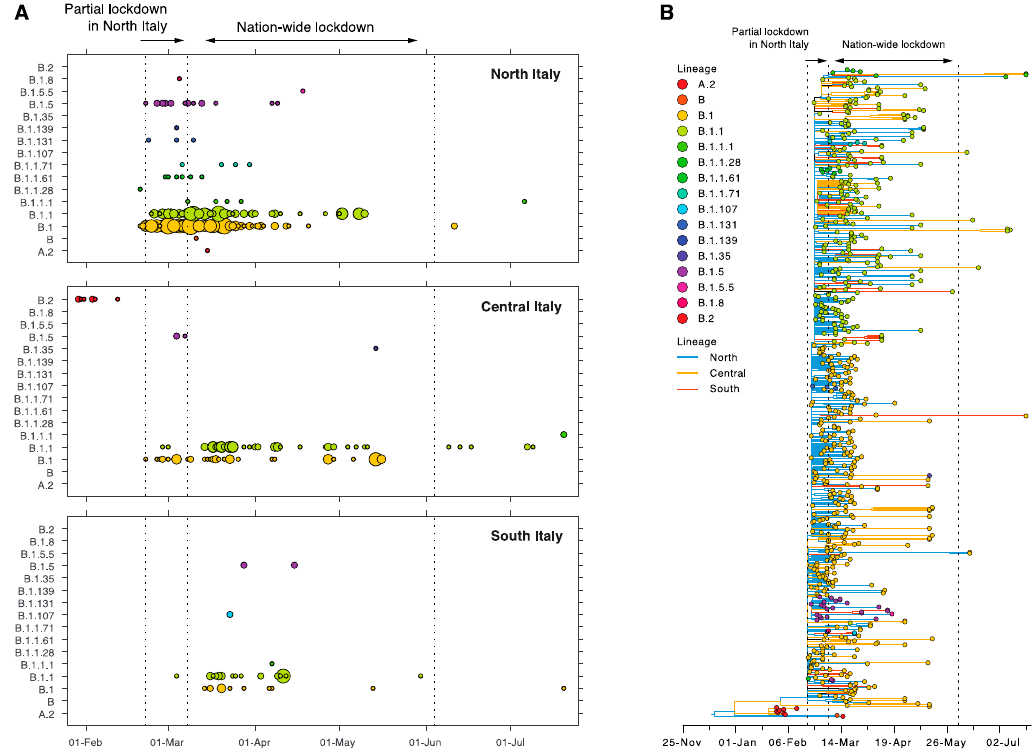
Figure 2. Distribution of SARS-CoV-2 lineages in Italy. ( A ) Number of sequences from different lineages across time for the three major geographic regions in Italy. The circle colour corresponds to each lineage and their size is proportional to the number of sequences sampled for a day for each lineage. Smallest circle = 1 sequence, largest circle = 15 sequences. ( B ) Italian sequences were extracted from a time-scaled tree (the global tree is shown in Figure S1). Branch lengths indicate the number of nucleotide substitutions per site and branches are coloured according to region; blue = North Italy, yellow = Central Italy, red = South Italy. Tip circles are coloured according to lineage.